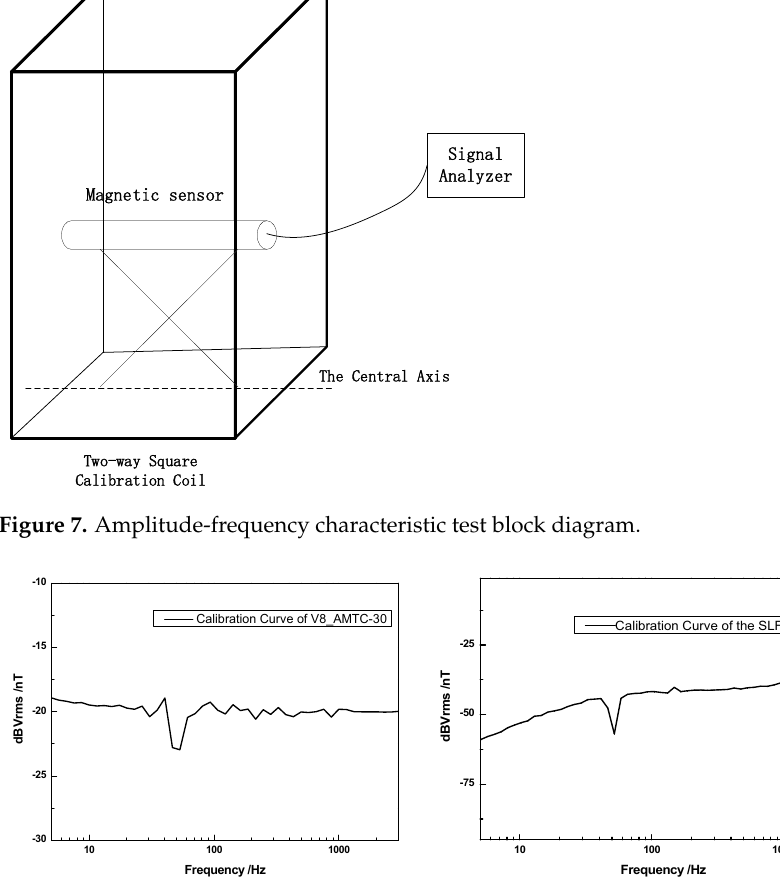
Figure 7. Amplitude-frequency characteristic test block diagram.